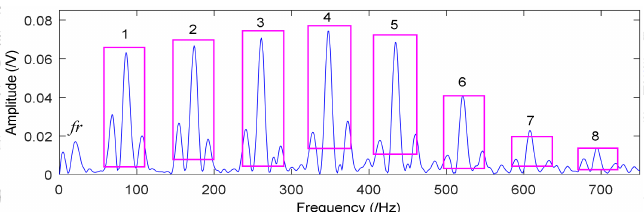
Figure 28. The diagonal slice spectrum after noise reduction using multiscale local projection.